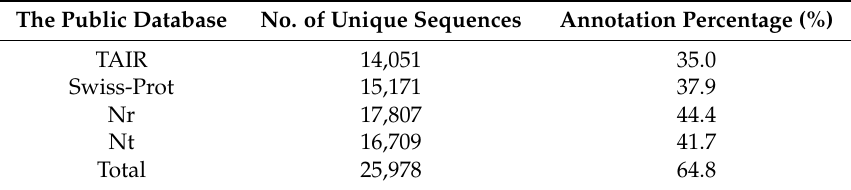
Table 1. Summary of the annotation rates of C. asiatica unique sequences in various public database. The Public